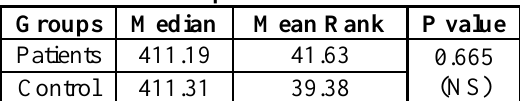
Table 3: The median and mean rank difference of saliva ACA (ng/ml) in SSc patients.